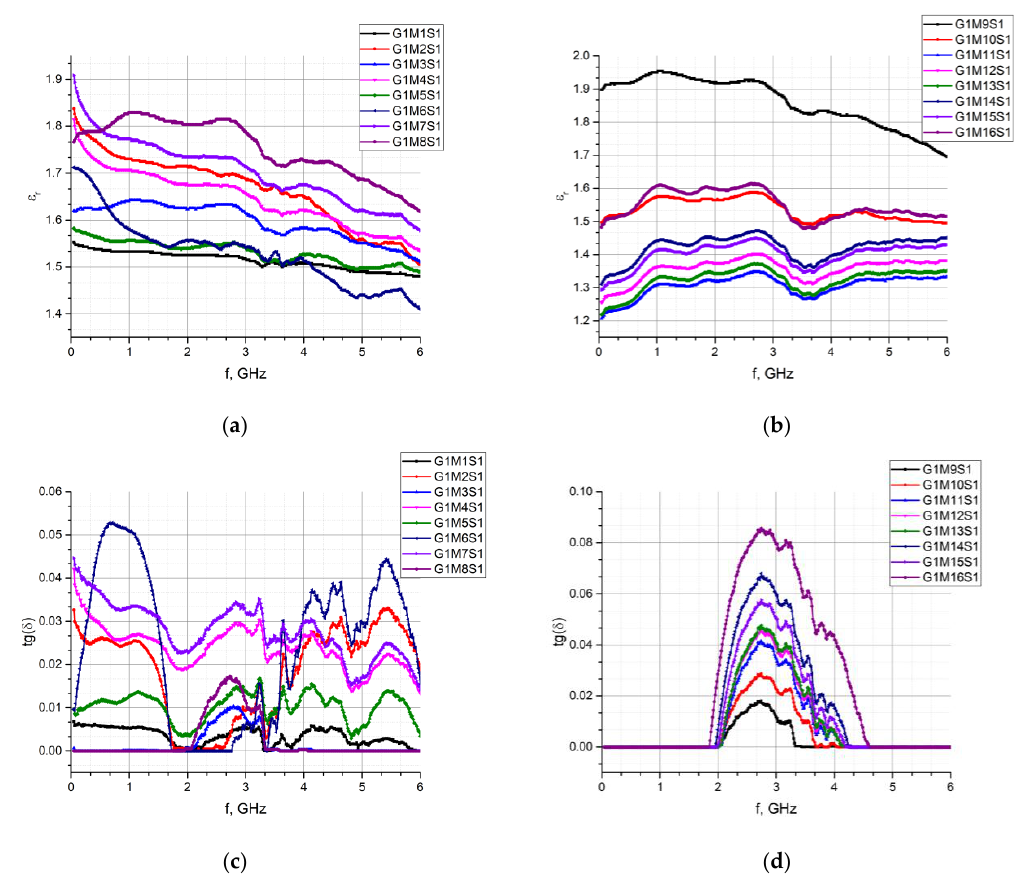
Figure 10. Comparison of dielectric parameters obtained in G1 group of fabrics: ( a ) ε r for G1M1S1 – G1M8S1; ( b ) ε r for G1M9S1 – G1M16S1; ( c ) tg δ for G1M1S1 – G1M8S1; ( d ) tg δ for G1M9S1 – G1M16S1.